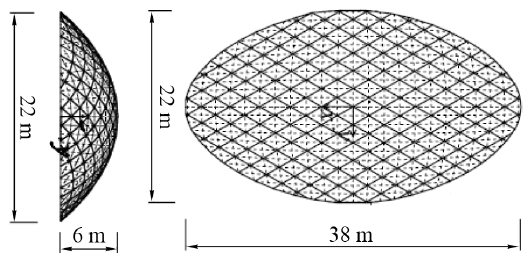
180 GPa. The initial stress of cables is 100 MPa.